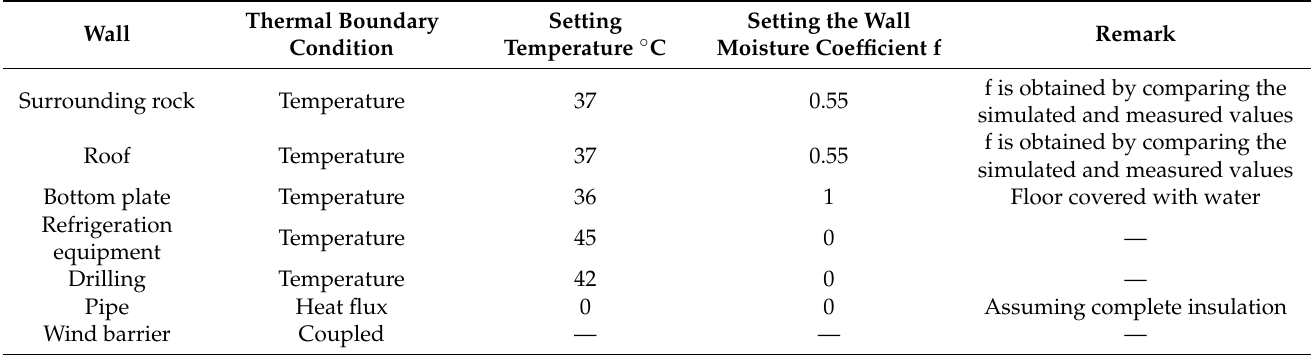
Table 3. Wall Boundary Condition Settings.